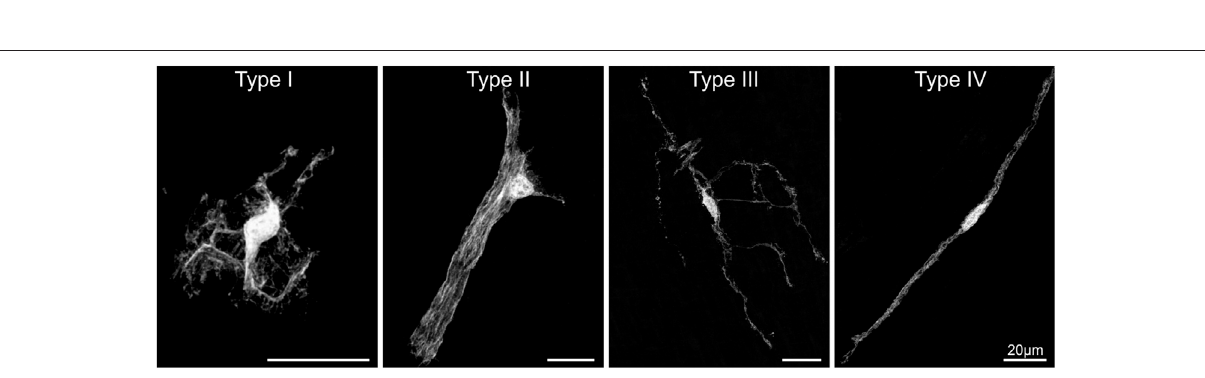
Frontiers in Cell and Developmental Biology |